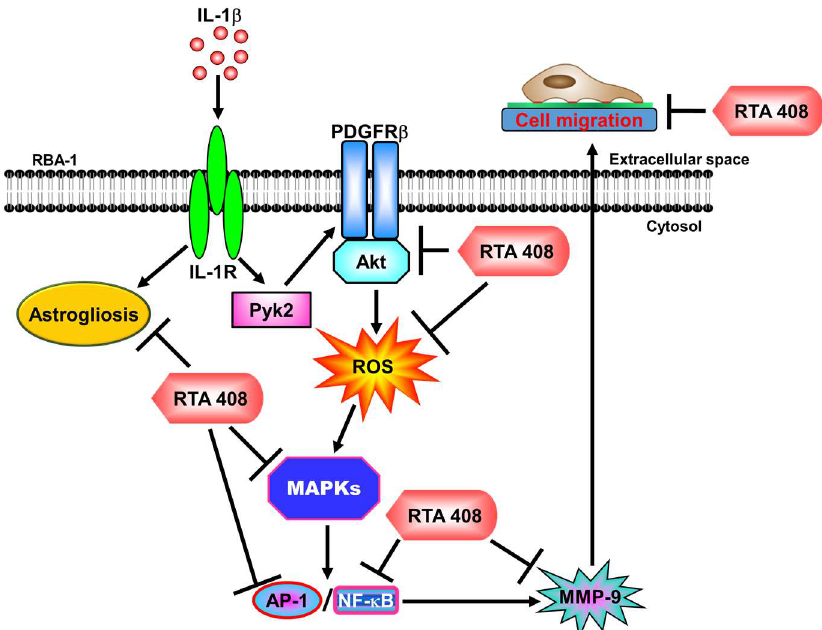
Figure 8. The schematic signaling pathways involved in RTA 408 inhibiting the IL-1 β -induced responses in RBA-1 cells. RTA 408 attenuates Pyk2, PDGFR β , Akt, MAPKs (p42 / p44 MAPK, p38 MAPK, and JNK1 / 2) phosphorylation and subsequently decreases NF- κ B and AP-1 activation, ultimately leading to inhibit MMP-9 expression and RBA-1 cell migration. RTA 408 also inhibits IL-1 β -induced astrogliosis. “ → ” means “activated”; “ ⊥ ” means "inhibited". PI3K is a heterodimeric protein consisting of a p85 regulatory subunit and a p110 catalytic